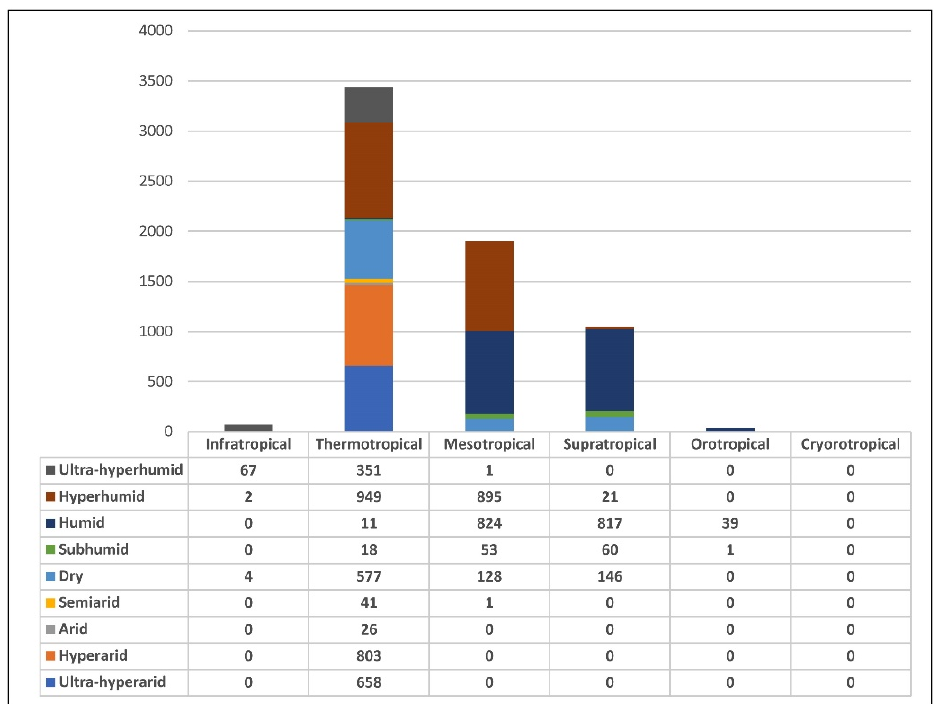
Figure 3. Frequencies of the plants of the RSBEVP expedition among bioclimatic belts and ombro-types.